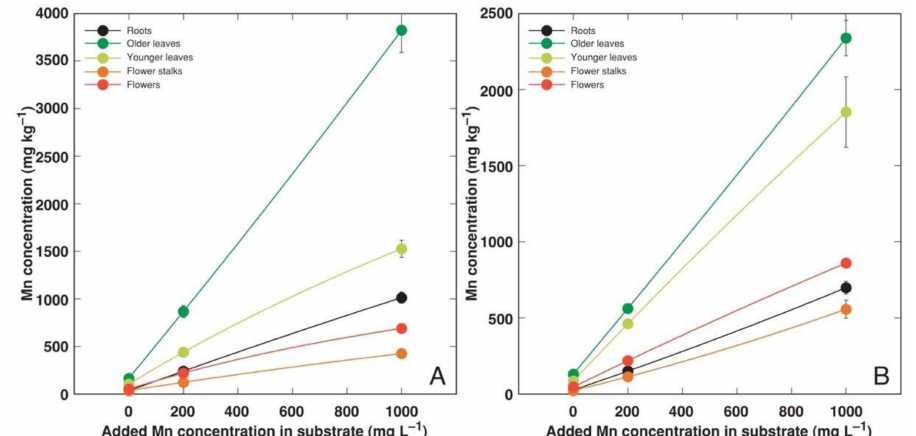
Figure 6. Effect of added Mn concentration in soil on Mn concentration in different parts of Armeria maritima plants of accession AM1 ( A ) and AM2 ( B ) after cultivation for 9 weeks. Data are means ± SE from 3 samples.